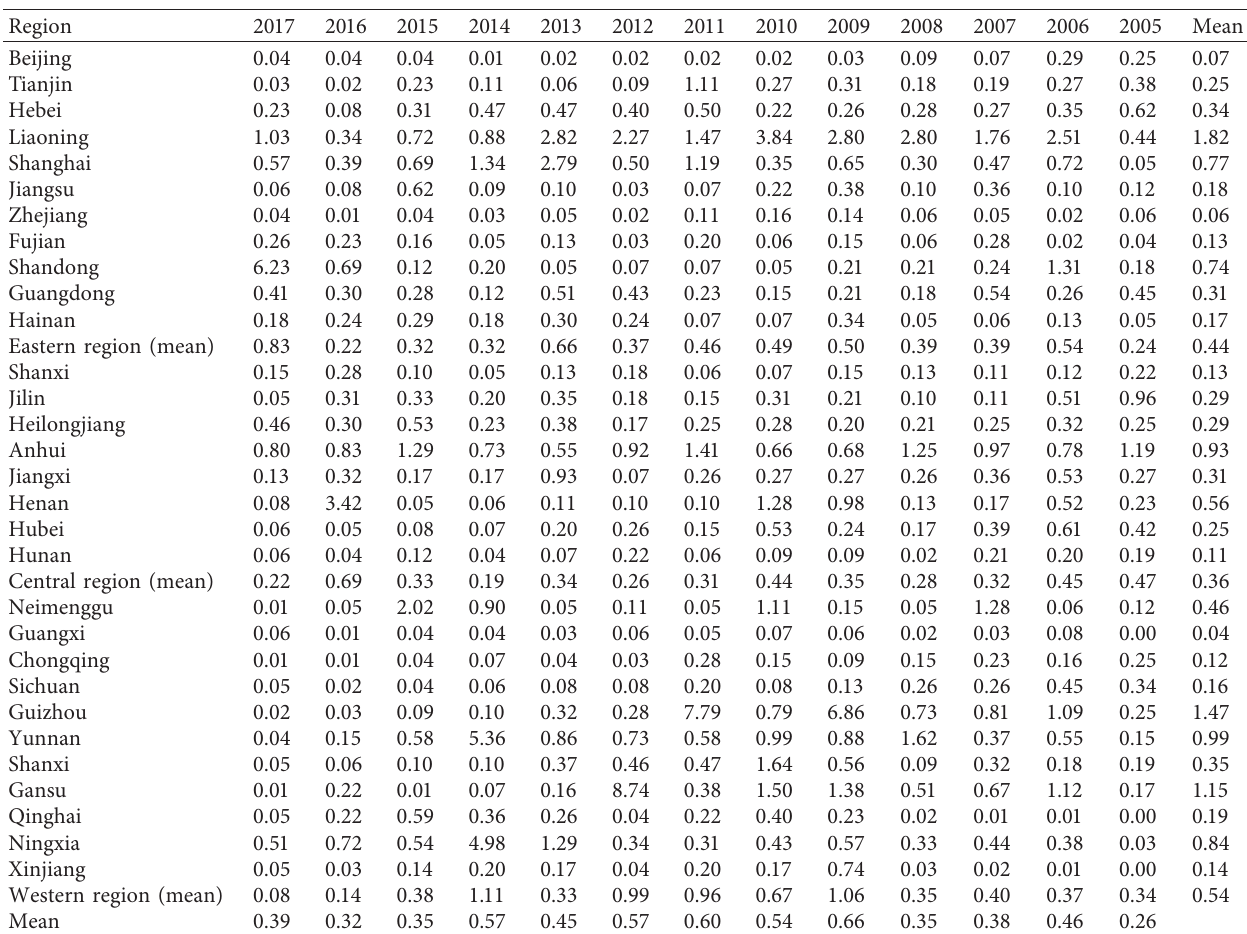
Table 3: Environmental regulation intensity in 30 Chinese provinces,